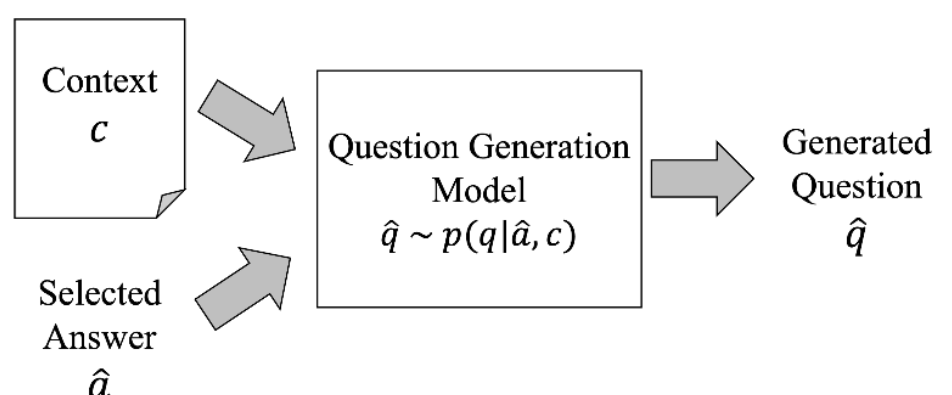
Figure 5. The inputs and the output of the Question Generation Model.